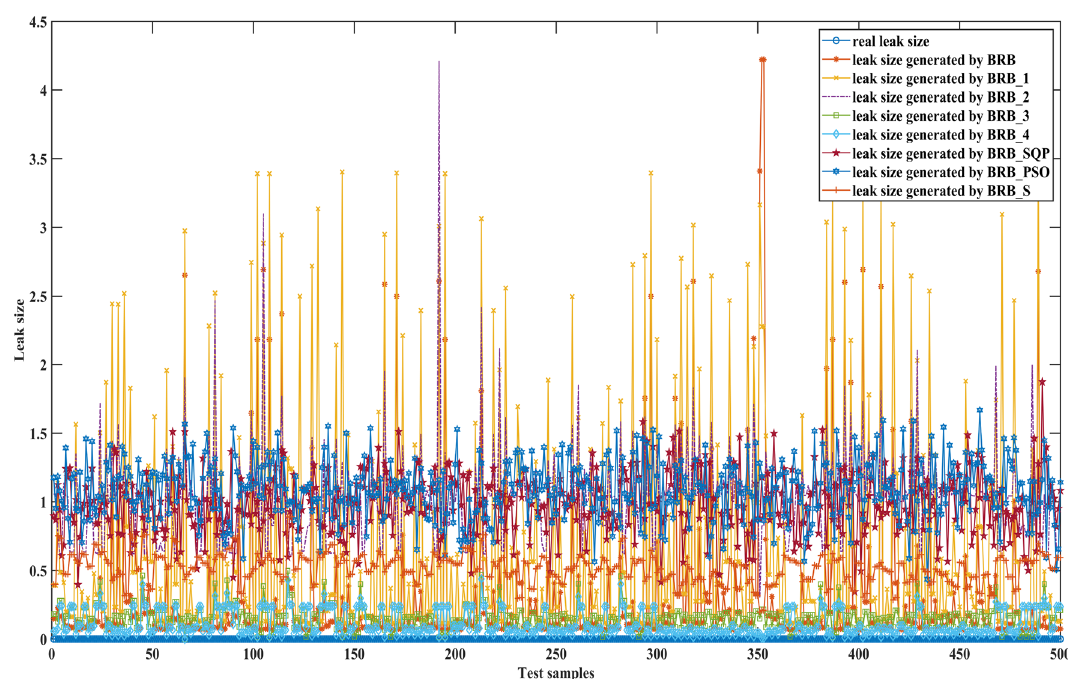
Figure 15. The 1–500 comparative results generated by different